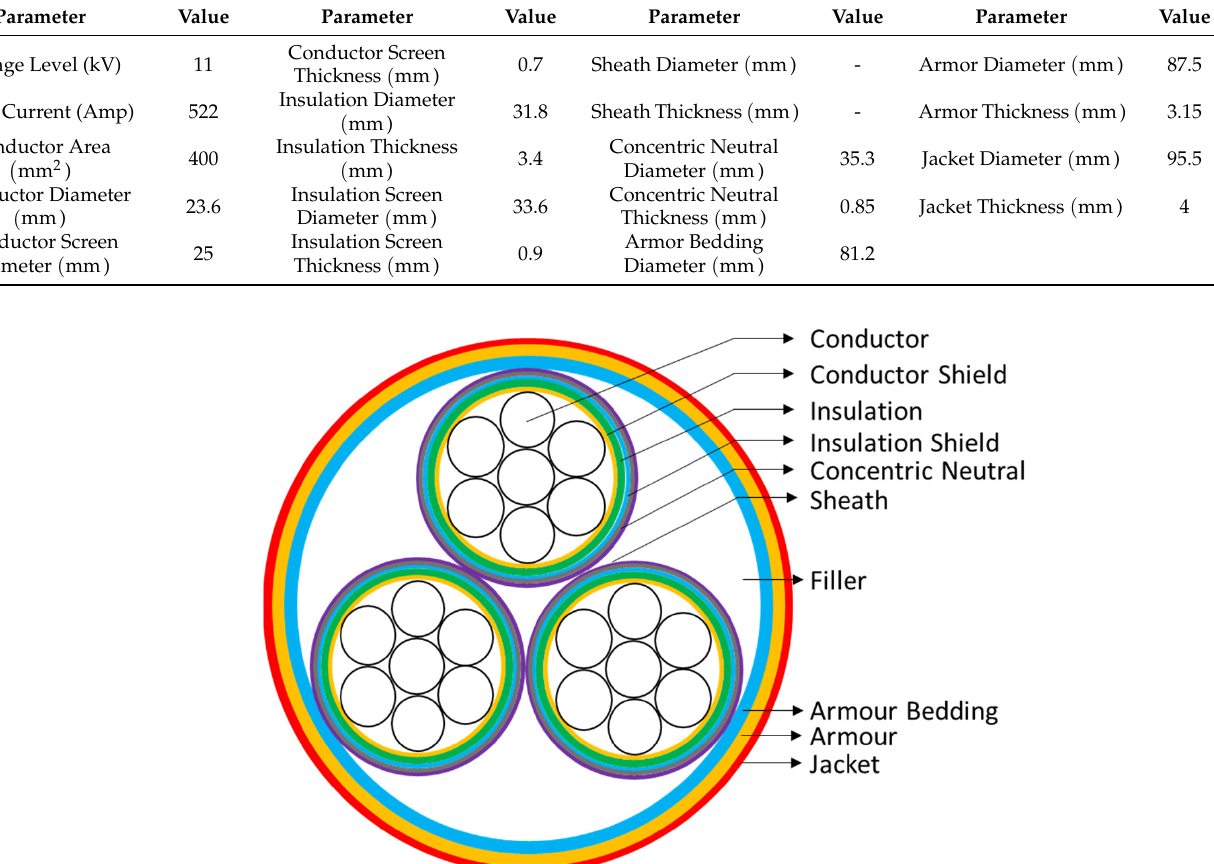
Figure 3. Layout of the 11 kV distribution cable.